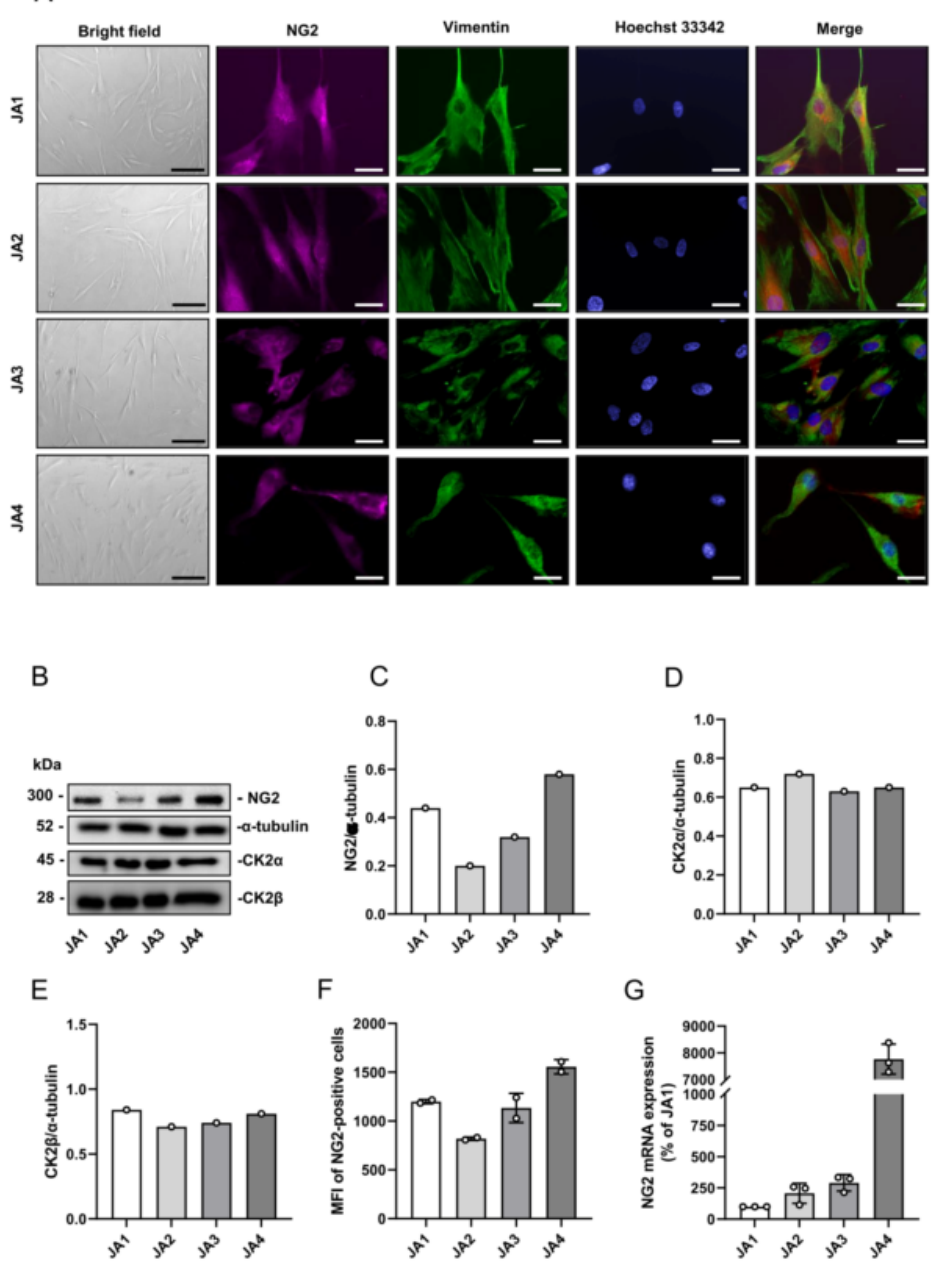
Figure 2. Expression of CK2 and NG2 in the patient-derived JA cells. ( A ) Bright field images (scale bars: 20 µ m) and immunofluorescence stainings (scale bars: 50 µ m) of NG2 (red), vimentin (green) and cell nuclei (blue) in the JA1–JA4 cells. ( B ) The JA1–JA4 cells were lysed and the expression of NG2, CK2 α , CK2 β and α -tubulin (as a loading control) was analyzed by Western blot. ( C – E ) Quantitative analysis of ( B ). Data are expressed as the relative density ratio of NG2/ α -tubulin ( D ), CK2 α / α -tubulin ( E ) and CK2 β / α -tubulin. ( F ) NG2 surface expression of the JA1–JA4 cells was detected by flow cytometry. Mean ± SD ( n = 2). ( G ) RNA was extracted from the JA1–JA4 cells and the gene expression of NG2 was examined by qRT-PCR (% of JA1). Mean ± SD ( n = 3).